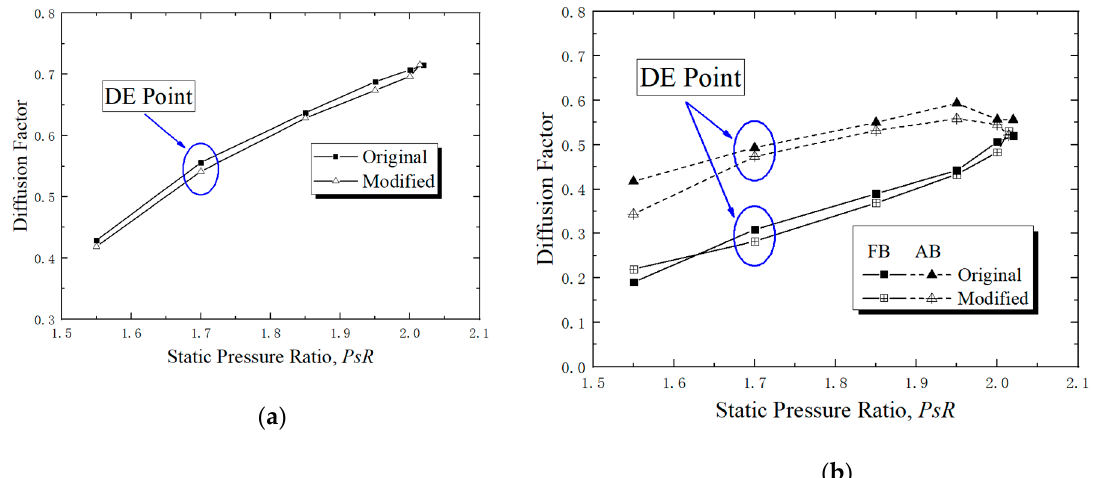
Figure 11. Comparison of the basic and optimized blade diffusion factors. Diffusion factor of the tandem blade, ( b ) Diffusion factor of the single blade.